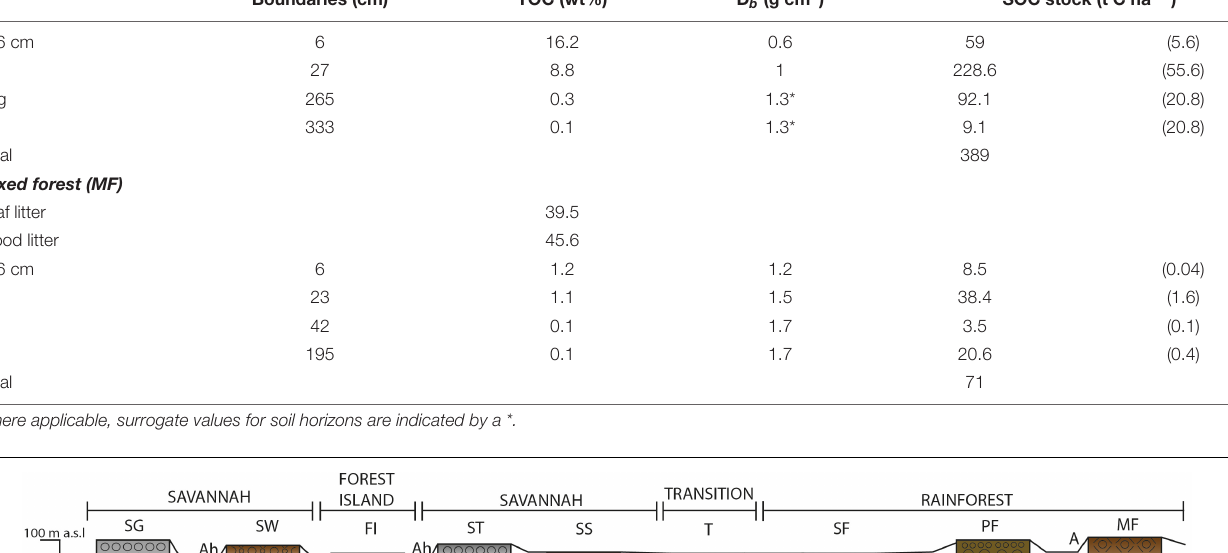
small amounts (see Supplementary Material for examples of a savannah and rainforest soils). This mineralogy is unlikely to have a significant effect on the physical protection or complexing of organic carbon, as the quartz, clay mineral kaolinite, ferric